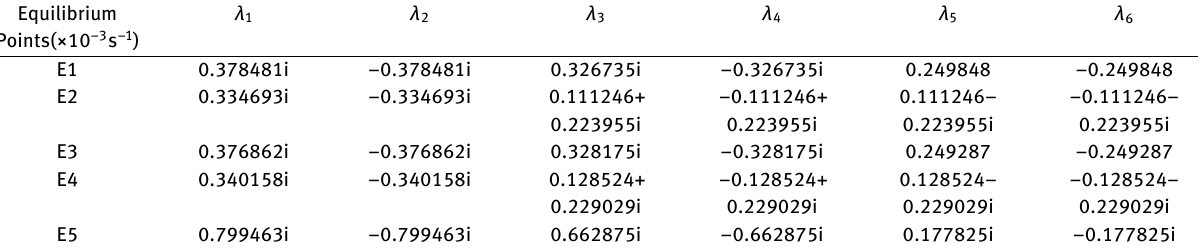
Table 2. Eigenvalues of the equilibrium points.